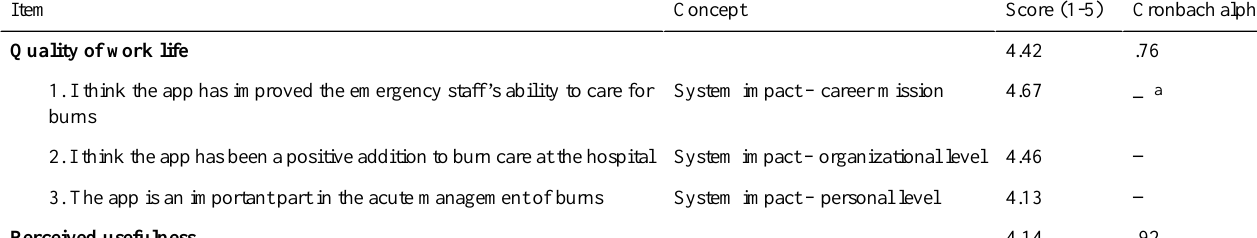
Table 6. Health-Information Technology Usability Evaluation Scale